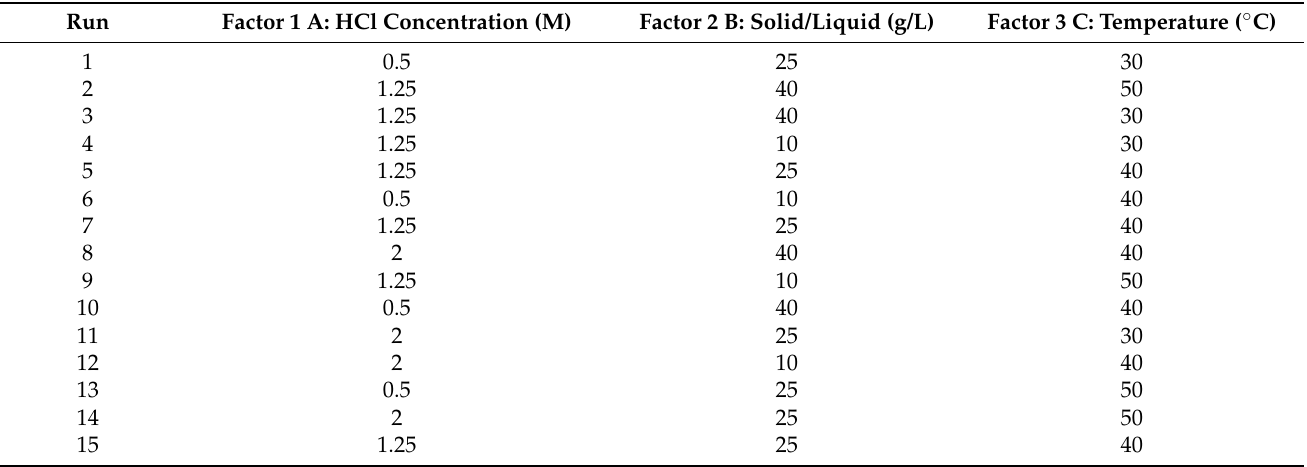
Table 1. Experimental design matrix (from DOE) for the leaching of RC1 and